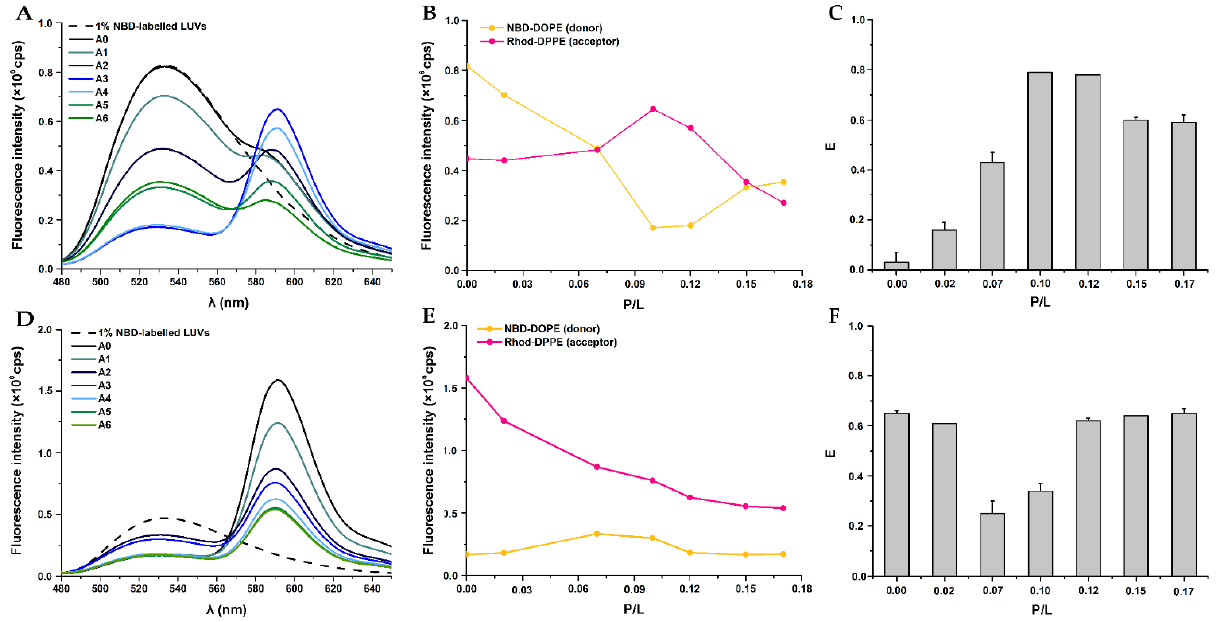
Figure 7. Evaluation of the fusion activity of W-BP100 in anionic LUVs by FRET using steady-state fluorescence spectroscopy. Two methodologies were tested: ( A – C ) the fluorophore mixing method and ( D – F ) the fluorophore dilution method. ( A , D ) Representative emission fluorescence spectra of NBD-DOPE and Rho-DPPE labelled LUVs in the absence (A0) and presence of increasing W-BP100 concentrations (A1–A6). Fluorescence spectra of single-labelled NBD-LUVs (donor) are represented by a dashed line. ( B , E ) Representative maximum fluorescence emission of NBD-DOPE ( λ em = 530 nm) and Rho-DPPE ( λ em = 590 nm) as a function of the P/L ratio. ( C , F ) FRET efficiency ( E ) between NBD-DOPE (donor) and Rho-DPPE (acceptor) as a function of the P/L ratio was calculated by Equation (2). Data are the mean ± SD of two independent experiments.